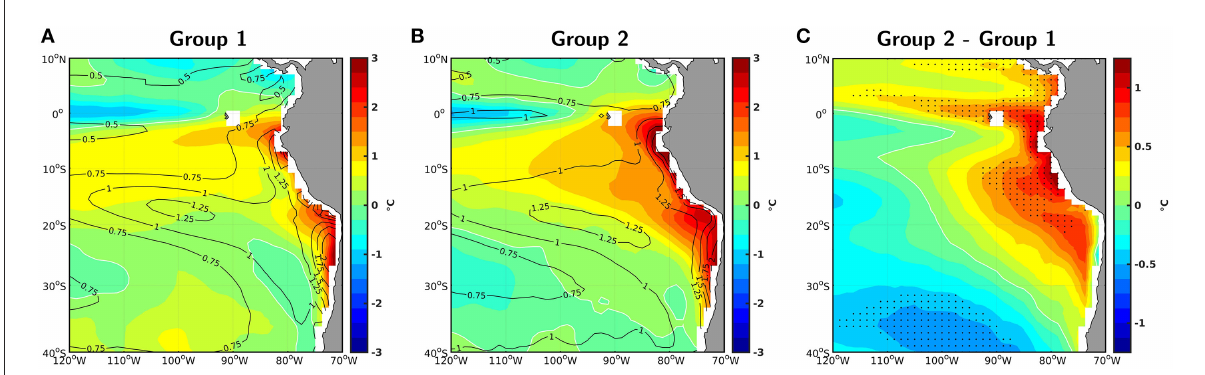
FIGURE8 Ensemble mean SST bias (in ◦ C) with respect to HadISST data (1948-2020) for (A) the models with a “strong” SPMM/E relationship (group 1), and for (B) those with a “weak” SPMM/E relationship (group 2). Groups are defined based on (A) . The contours in (A) and (B) stands for the standard deviation of the mean SST bias amongst the corresponding ensemble (also in ◦ C). (C) Difference between (B) and (A) . Dots show grid points where the difference between the 2 groups is statistically significant at 90% based on a two-sample Student’s t